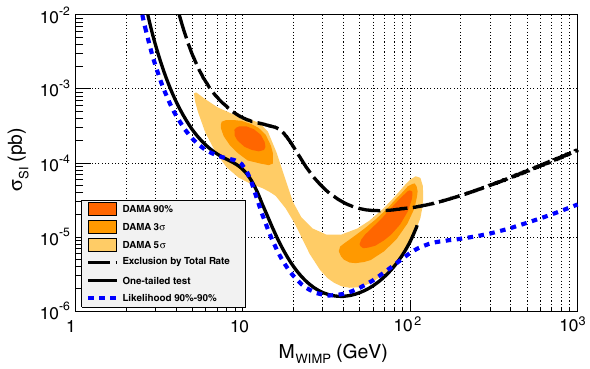
Fig. 5 Result of the maximum likelihood test ratio for the detection limit in the [1,6] keV ee window at 90% C.L. (when critical limit is at 90% C.L.) with 50 energy bins and segmented detector of ANAIS-112 after 5 years of measurement (short dashed blue line). The exclusion by total rate for the spin-independent WIMP-nucleon cross section of ANAIS-112 is the long dashed black line. DAMA/LIBRA regions at 90%, 3 σ and 5 σ are also shown [21]. The detection limit is the solid black